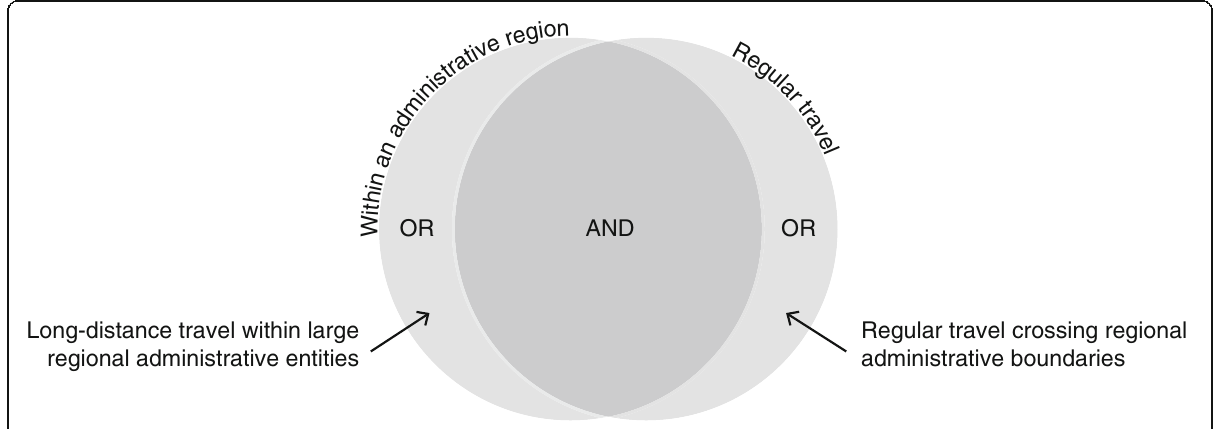
Fig. 1 Venn diagram for the outer boundary of regional travel. Regular travel means that trips are made daily to weekly in general